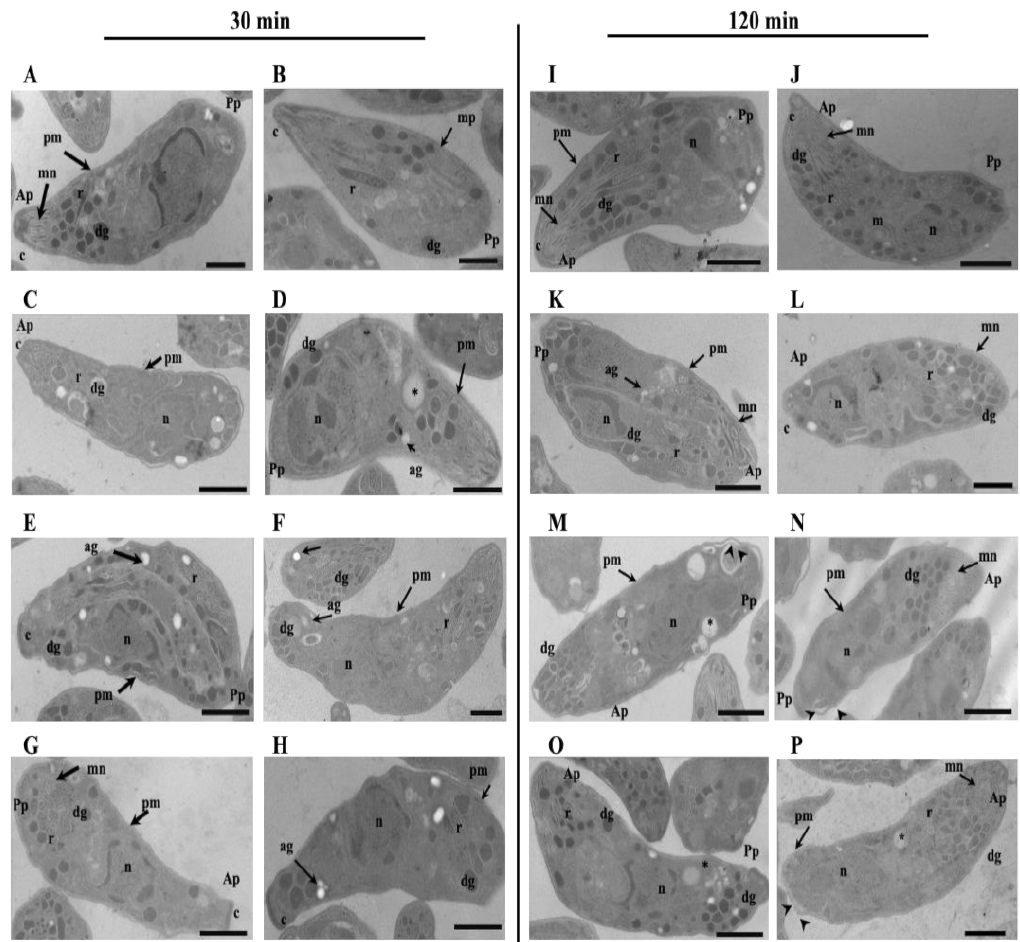
Figure 6. Effect of DHEA in the ultrastructure of Toxoplasma gondii extracellular tachyzoites. Morphology of extracellular tachyzoites drug exposed by ( A – H ) 30 min and ( I – P ) 120 min. ( A , I ) untreated tachyzoites; ( B , J ) tachyzoites exposure to ethanol. Extracellular tachyzoites exposure to DHEA ( C , K ) 10 µ M, ( D , L ), 100 µ M, DHEA/S-P ( E , M ) 10/600 µ M, ( F , N ) 10/800 µ M; or ( G , O ) 200 µ M, ang ( H – P ) 800 µ M. Ap, apical pole; Pp, posterior pole, c, conoid; mn, micronemes, r, rhoptries; dg, dense granules; pm, plasma membrane; ag, amylopectin granules; n, nucleus; asterisks, empty cytoplasmic vacuoles; arrow heads, waviness and separation of parasite plasma membrane. Bars = 1 µ m.